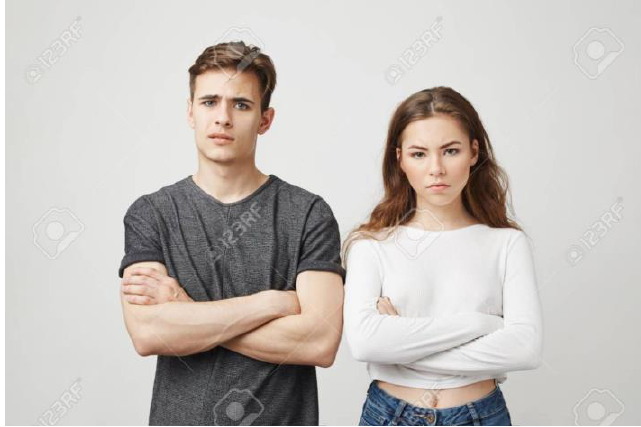
Figure 29. Consider one picture from the data set 2 [55].